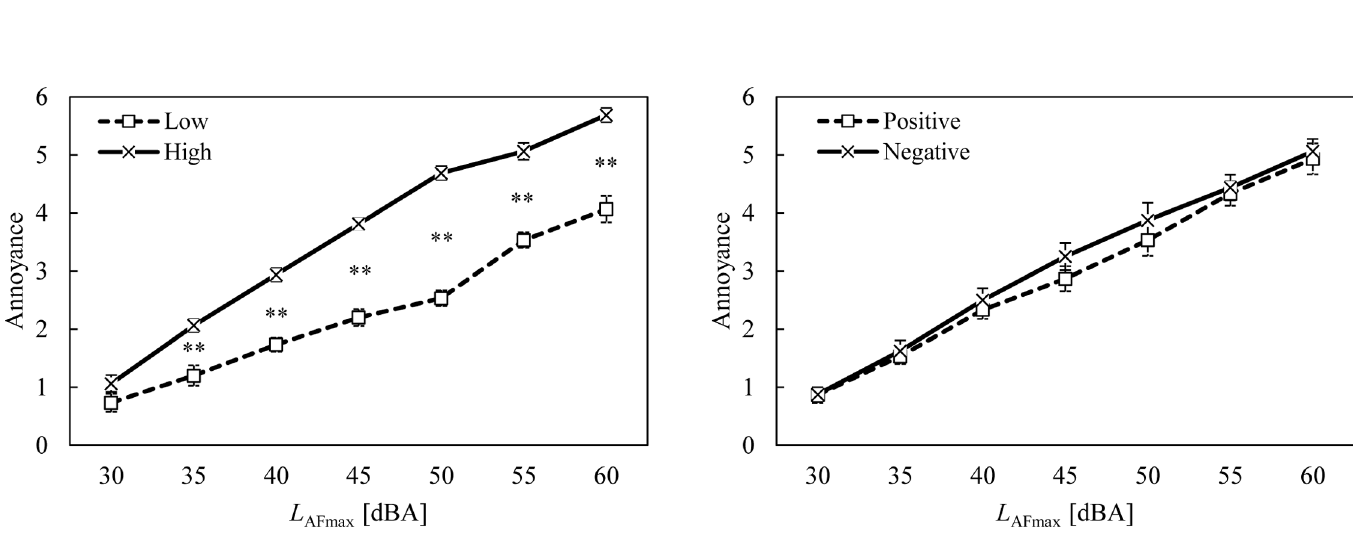
Fig 3. Ratings of noise annoyance for low ( □ ) and high (×) noise-sensitivity groups and positive ( □ ) and negative (×) attitude groups as a function of noise level. Error bars indicate standard errors. Asterisks indicate significant differences between means according to the Mann-Whitney U test ( (cid:3) p < 0.05 and (cid:3)(cid:3) p < 0.01).